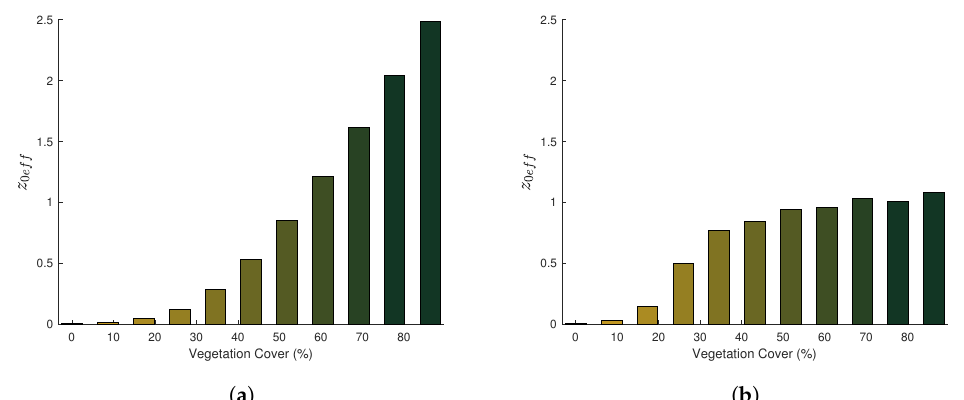
Figure 3. Effective roughness length z 0 ef f in meters for single-layer ( a ) and multilayer SBL scheme ( b ) as a function of vegetation percentage for each experiment. The colors represent increasing vegetation